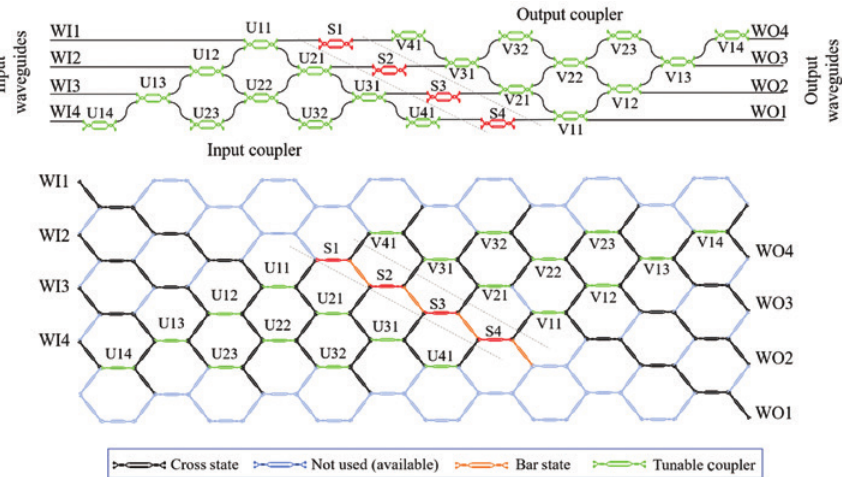
Figure 17: An example of the application of the singular value decomposition method to implement a universal non-unitary transformation emulated thorugh a triangular interferometer emulated by an hexagonal waveguide mesh.